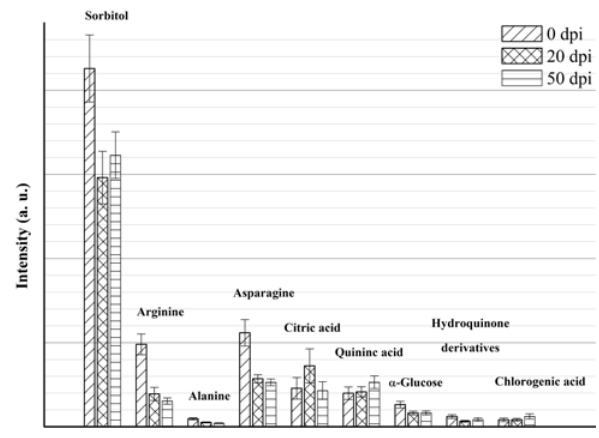
Figure 4. NMR signal distribution of selected metabolites at for pear leaf samples from 0 dpi, 20 dpi and 50 dpi treat-